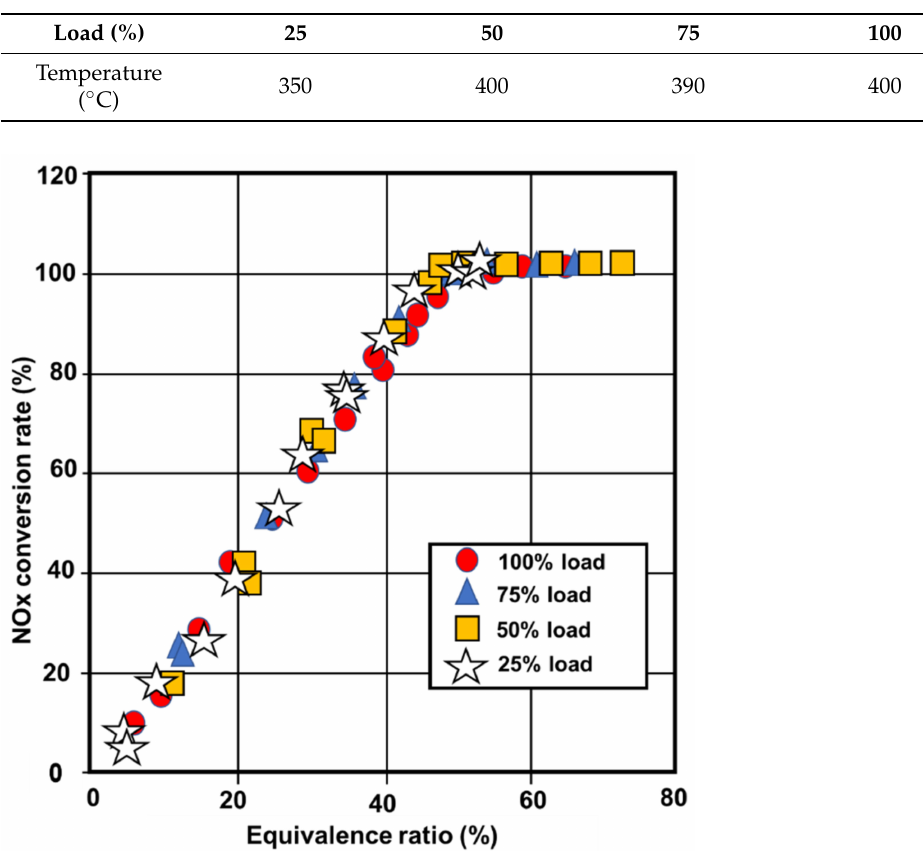
Figure 38. NOx conversion rate values against urea–water solution flowrates [28]. Table 14. Exhaust gas temperatures, adapted from Yoichi et al. [28].